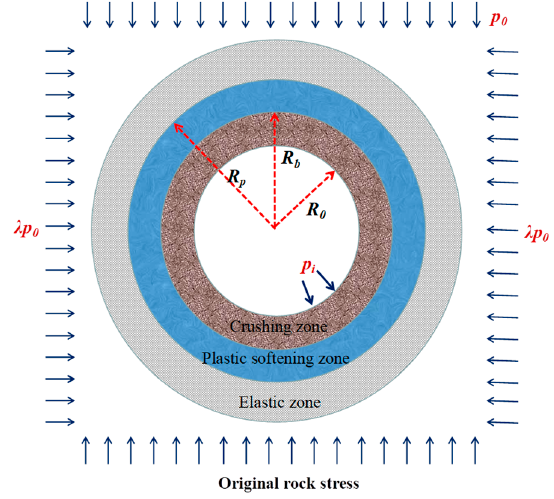
Figure 1. Mechanical model of tunnel surrounding rock.